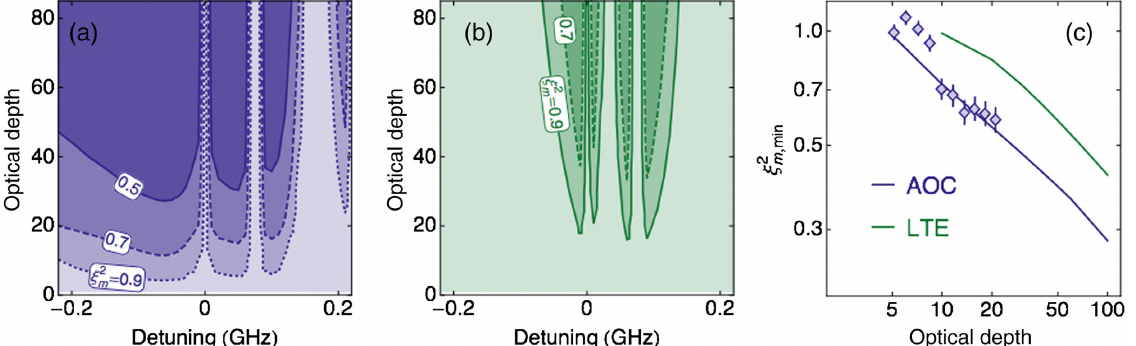
FIG. 5. Theoretical calculation of spin squeezing as a function of optical depth and probe detuning for (a) the AOC strategy and (b) the LTE strategy with our experimental parameters. Contours indicate the minimum achievable metrologically significant squeezing ξ 2 m; with respect to N L , with values indicated, as a function of detuning Δ and OD. (c) The blue diamonds represent the observed spin squeezing ξ m as a function of optical depth for the AOC measurement with N L ¼ 2 × 10 8 photons. The solid curves show the theoretically predicted minimum achievable squeezing, optimized with respect to both N L and Δ , for the AOC measurement (solid blue line) and the LTE measurement (solid green line). The scaling of each curve is roughly ξ 2 ∝ OD − 1 = 2 , so the advantage for AOC continues also to large